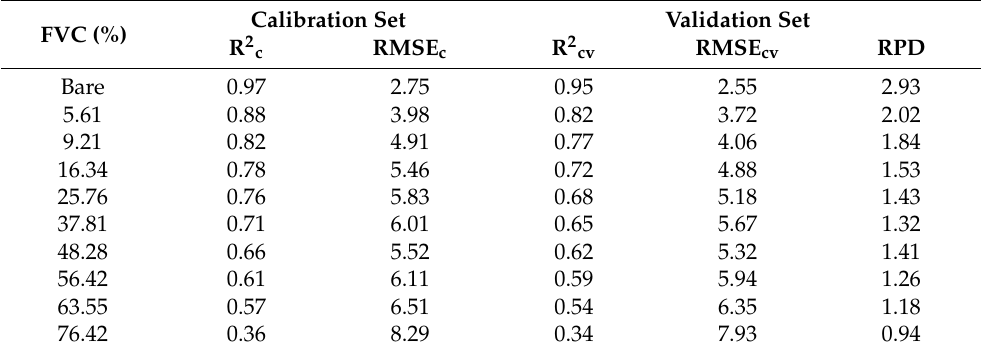
Table 1. Estimation accuracy of soil salt content by original mixed spectra at different FVCs. Calibration Set Validation FVC (%)